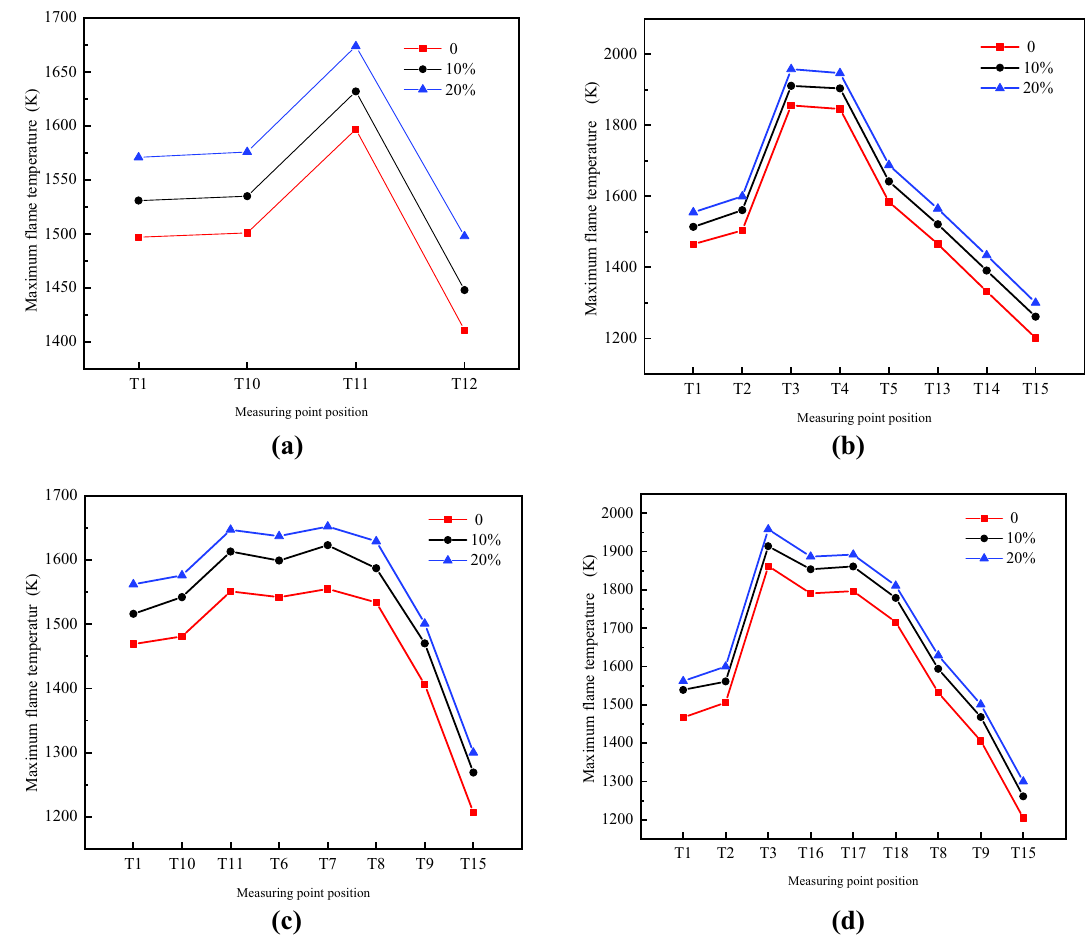
Figure 6. Maximum flame temperature of all measuring points. ( a ) O–A–B–C branch; ( b ) O–A–D–F–H–G branch; ( c ) O–A–B–E–H–G branch; ( d ) O–A–D–E–H–G